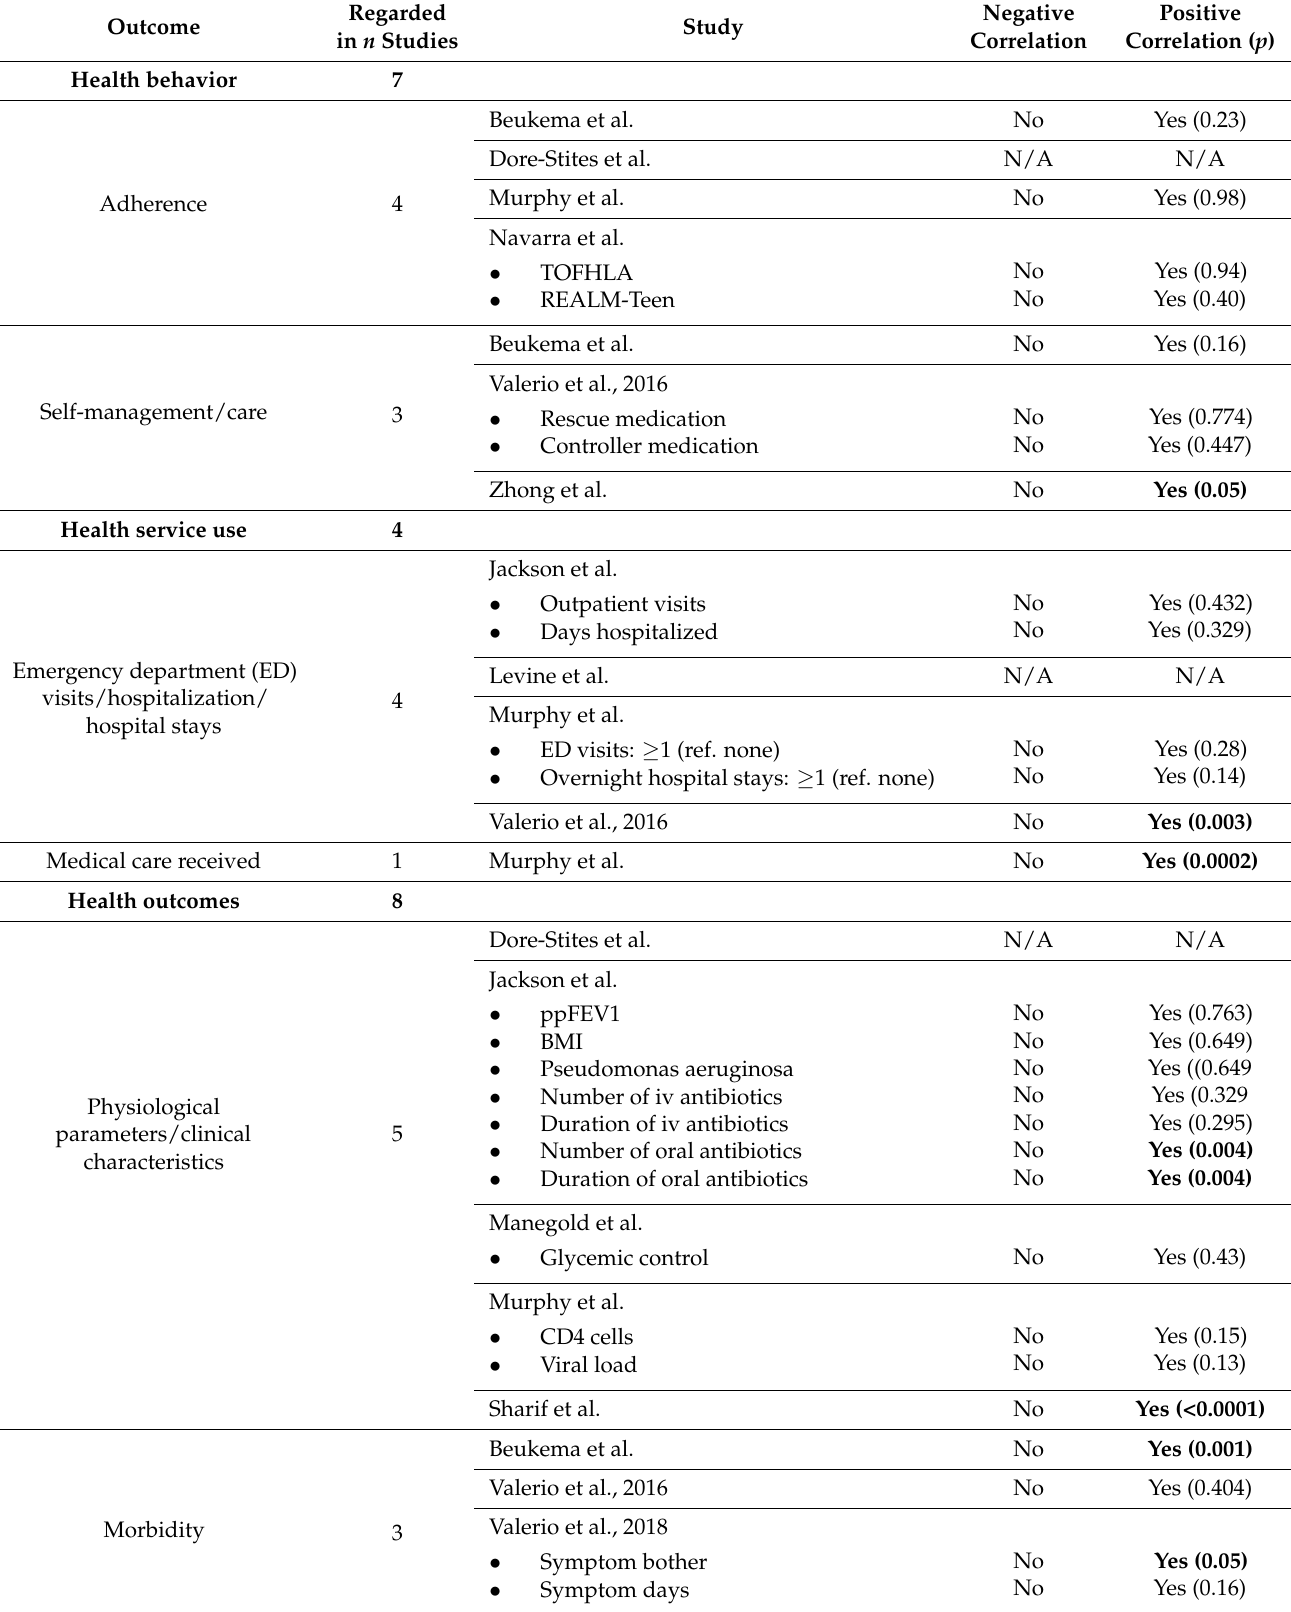
Table 4. Influence of health literacy on health